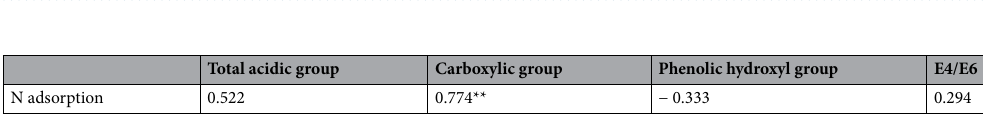
Table 4. Correlation between nitrogen (N) adsorption and different acidic functional groups. **Significant correlation at 0.01